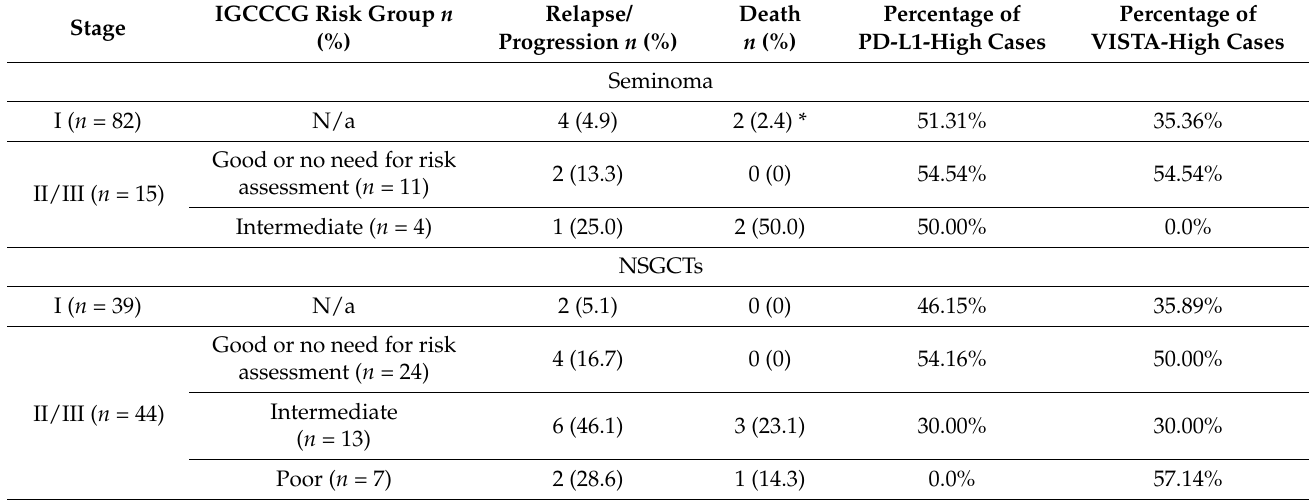
Table 3. Frequency of events according to stage and histology. * death unrelated to testicular cancer. Abbreviations: PD- L1—Programmed death-ligand 1; VISTA—V-domain immunoglobulin suppressor of T cell activation; n /a—not applicable; NSGCTs—nonseminomatous germ cell tumors.